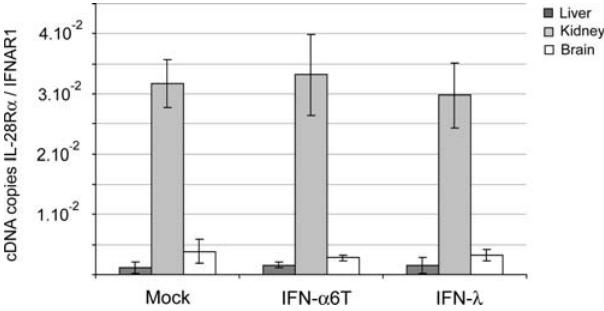
Figure 6. IL-28R a expression exhibits tissue specificity. IL-28R a and IFNAR1 expressions were determined 7 days after electroinjection of plasmids coding for MuIFN- l 3 (right) or MuIFN- a 6T (center), or after electroinjection of an empty vector (left), in 6 week-old BALB.A2G-Mx1 mice. IL-28R a and IFNAR1 expressions were measured by real-time RT- PCR. Results are expressed as means and SD of the ratio between IL28R a and IFNAR1 cDNA copies.